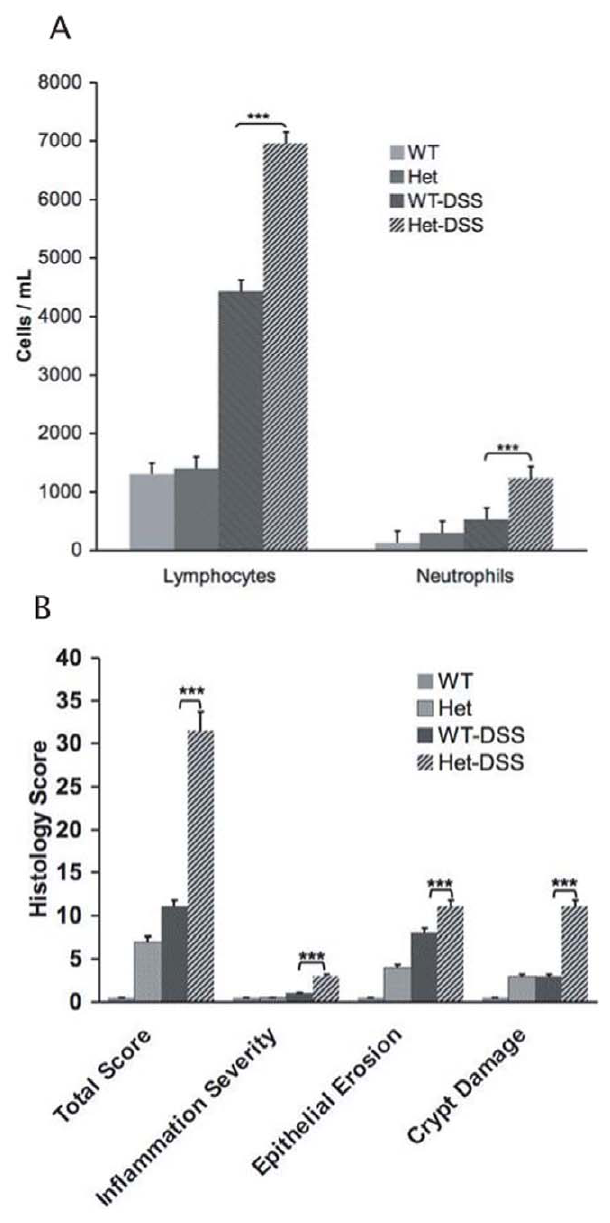
Figure 3. Blood cell counts and histological analysis of colons. A. Increase in numbers of lymphocytes p , 0.0114 and neutrophils p , 0.0001 in DSS-treated TC-PTP + / 2 mice compared to DSS-treated TC- PTP + / + . B. The mean histology activity scores of colon tissue sections of TC-PTP + / + (WT) (0.3 6 0.34), TC-PTP + / 2 (Het) (7 6 0.55), DSS-treated TC- PTP + / + (WT-DSS) (12 6 0.48) and DSS-treated TC-PTP + / 2 (Het-DSS) (32 6 0.67) mice. Analysis was performed blinded by pathologist on a scale from 0 to 40 (see Methods).